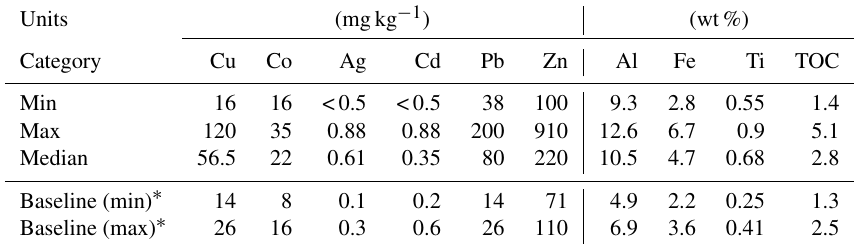
Table 1. Summary of Utoy Creek data from the <63µm fraction of bed sediment samples ( n = 47). Units (mgkg − 1 )